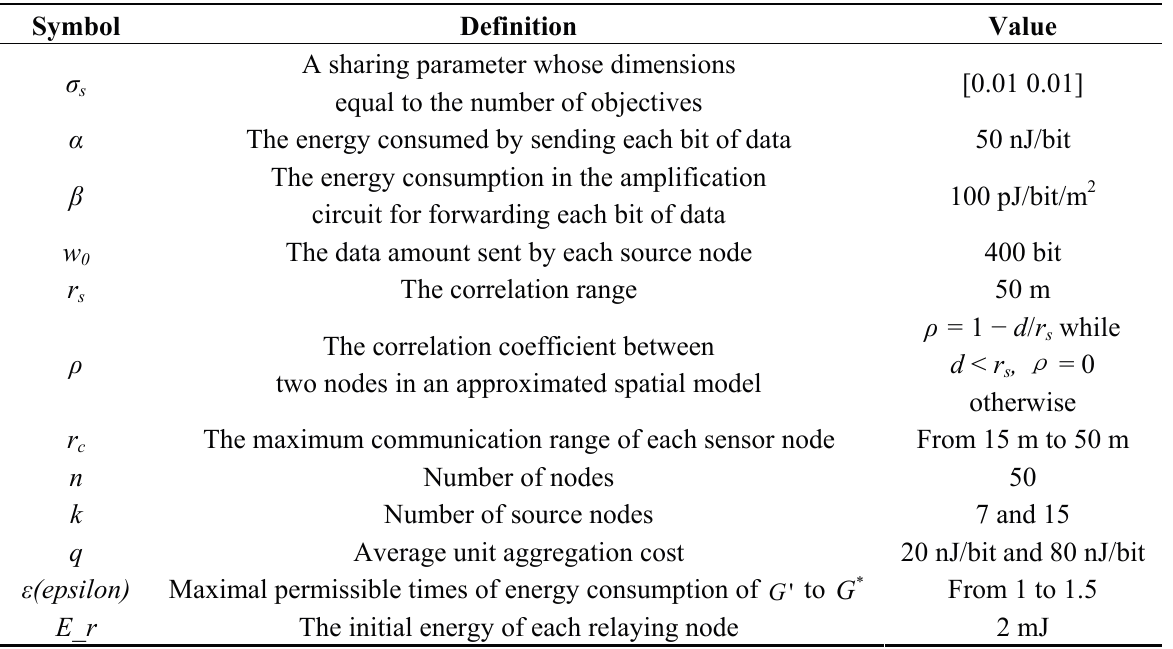
Table 1. Parameter table.